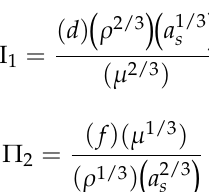
Figure 6. R a Contact angle (CA) hysteresis, as well as advancing and receding CAs for deionized water on smooth and roughened surfaces coated with FluoroSyl. The final CAs of spread droplets after vibration (retraction angle) are plotted as an “x”.